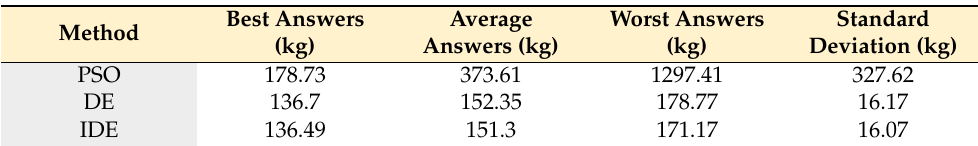
Table 8. Comparison of the proposed method with other methods for reducing gas emission without considering the limitations of upstream network power exchange.